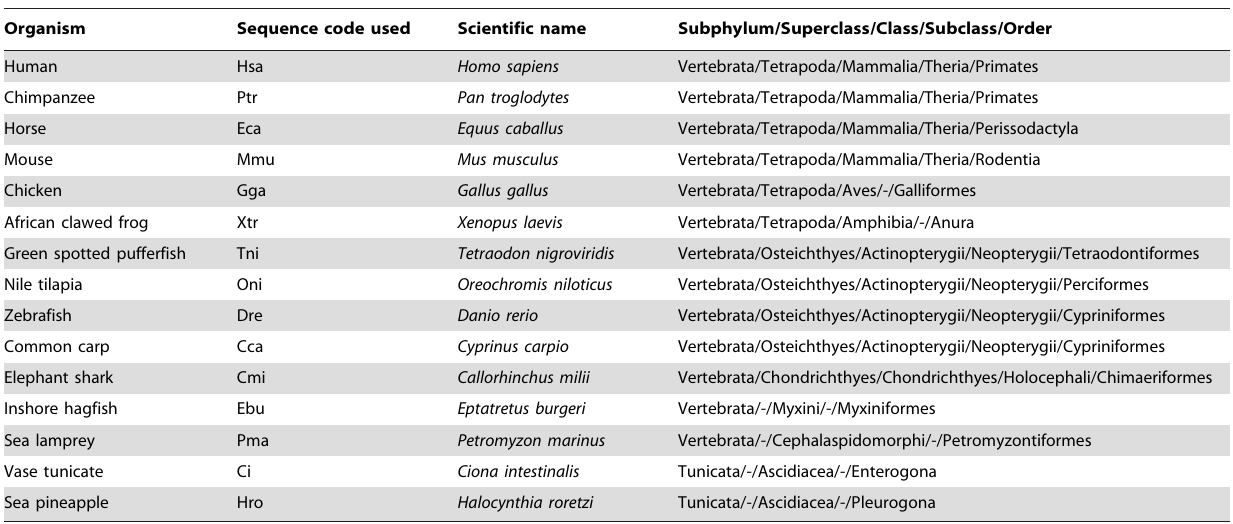
Table 1. Chordate genomes and EST assemblies utilized for the integrin phylogenetic analysis.